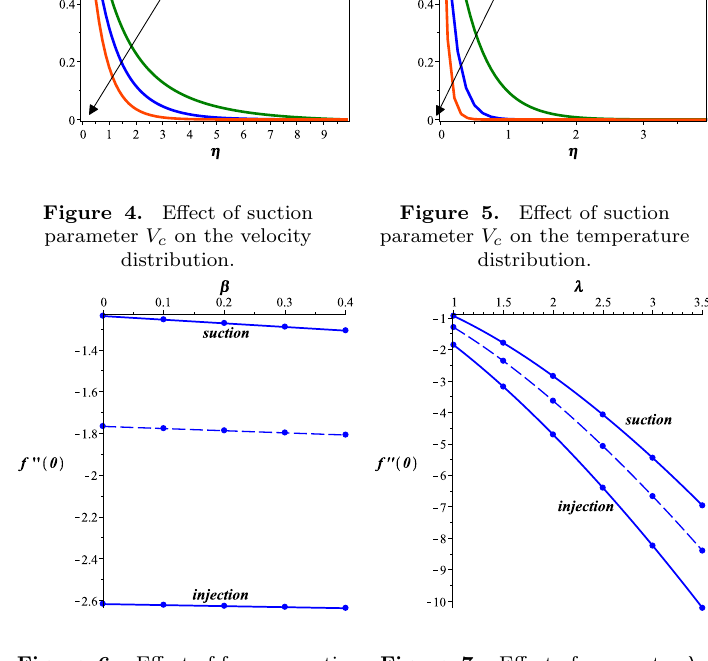
Figure 3. Effect of Prandtl number Pr on the temperature for V c = − 1.